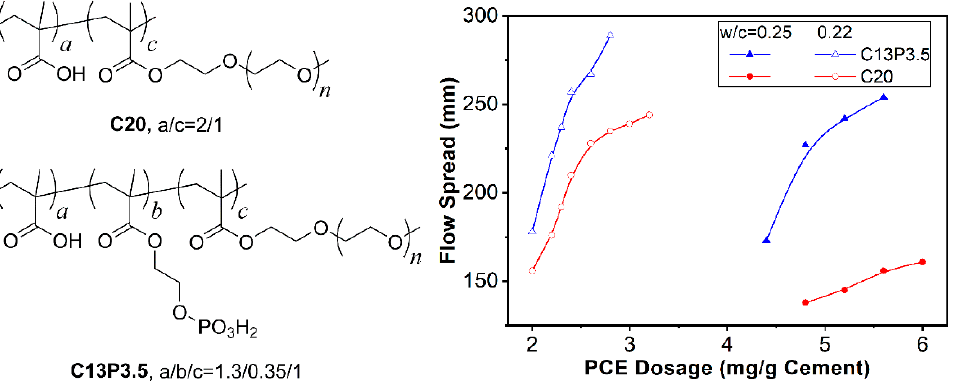
Figure 8. Chemical structure of different PCEs ( left ) and the performance in cement paste ( right ). Compared with C20 (containing only carboxylic groups), C13P3.5 contained a small fraction of phosphate groups. The theoretical charge density and molecular weight distribution of C13P3.5 were similar to those of C20. The performance of C13P3.5 was much better than for C20, especially at high dosages.